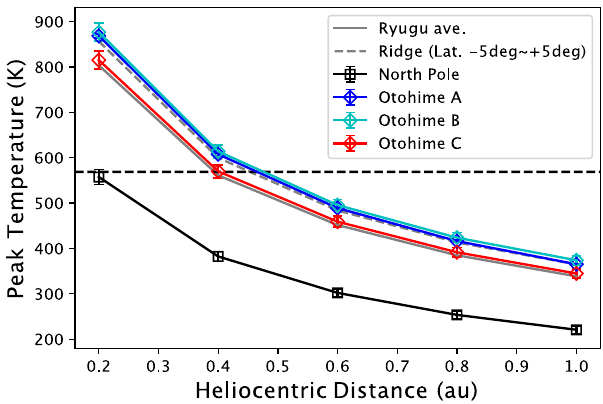
Fig. 9 Diurnal peak temperature at equinox as a function of heliocentric distance. North pole (black) and Otohime Facets (A: blue, B: cyan, C: red) are compared with the Ryugu average (gray solid line) and the equatorial ridge (gray dashed line). The equatorial ridge is de fi ned as latitude from 5°S to 5°N. 570 K where phyllosilicates start to decompose is shown by black dashed horizontal line. North pole is kept lower than 570 K at 0.4 au, while Otohime Saxum is heated higher than 570